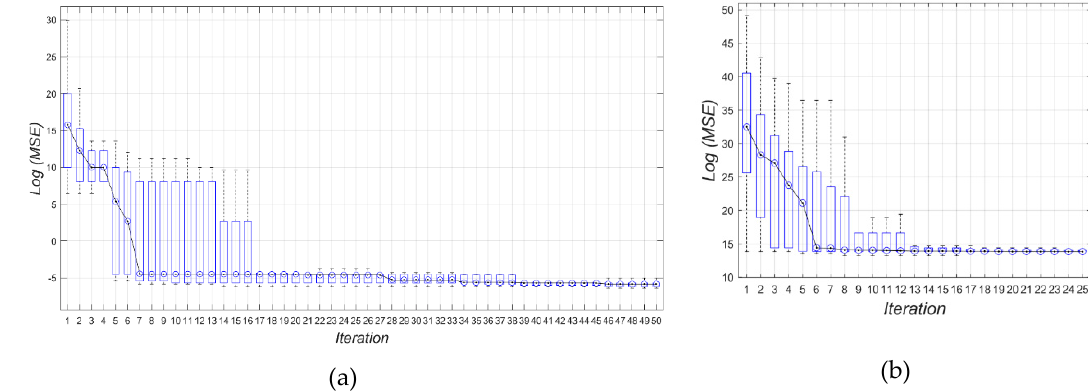
Figure 5. Convergence curve for the ( a ) Polish dataset errors using LCB-BO and ( b ) Brazilian dataset errors using EI-BO, optimized ESN. The trend line is the median value, while the boxplots show the quantiles over the 50 runs.